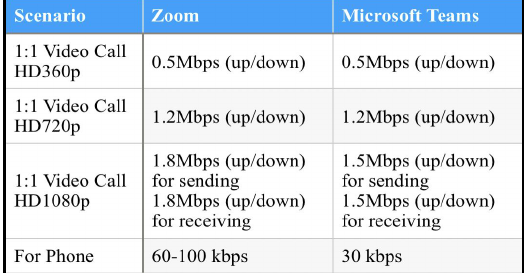
Figure 11. Bandwidth requirements for video calling in Zoom as compared to Teams